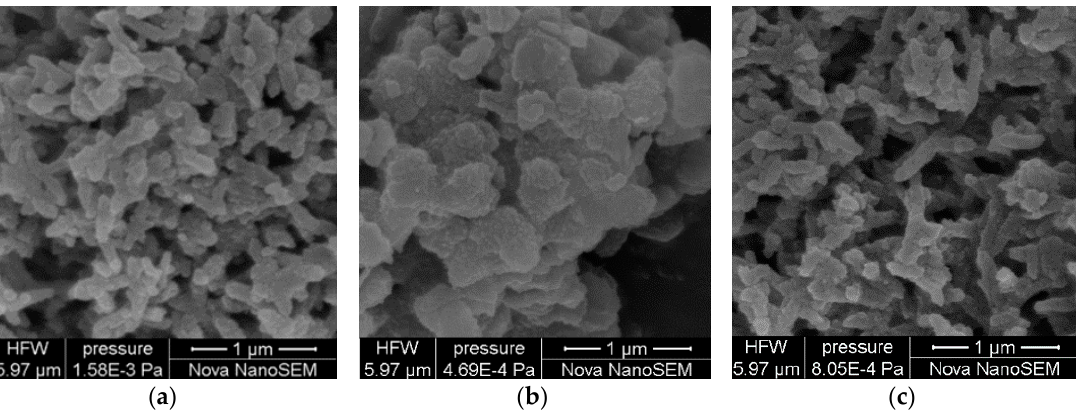
Figure 4. SEM image of PANI-HCl, PANI-SSA, and PANI-HCl/SSA. ( a ) PANI-HCl; ( b ) PANI-SSA; ( c ) PANI-HCl/SSA.